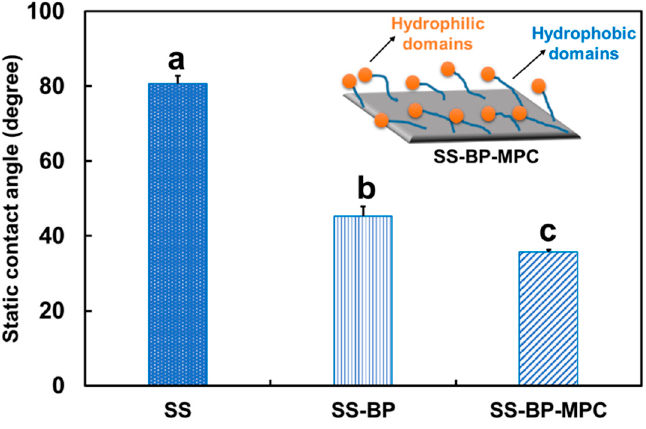
Figure 5. Static water contact angles for pristine SS, SS-BP, and SS-BP-MPC composites (n = 3). Data with different letters mean they are significantly different on multiple comparison at α = 0.05 using the Tukey test. The inserted diagram shows a schematic diagram of the collapsed MPC chain on the substrate surface.